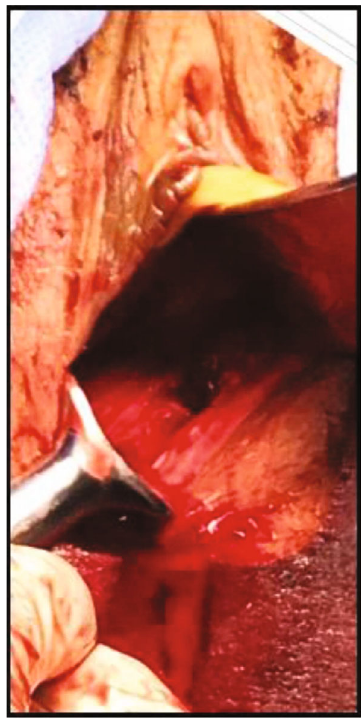
Figure 2: Picture showing the vaginal laceration through which the fractured bony fragment was assessed for irrigation and